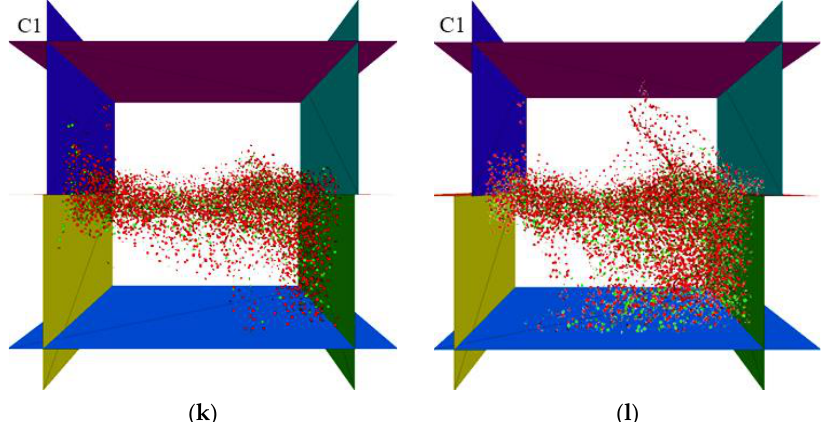
Figure 8. Change of fractures in the numerical model of slip zone soil under different cycle loading in ( a – d ) confining pressure = 200 kPa, ( e – h ) confining pressure = 100 kPa, and ( i – l ) confining pressure = 50 kPa. ( a ) V = 0.5 cm/s, confining pressure = 200 kPa. ( b ) V = 0.9 cm/s, confining pressure =